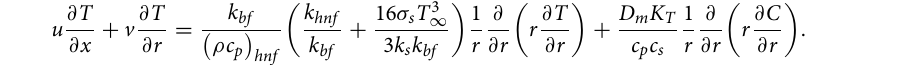
and leaving the second, ∞